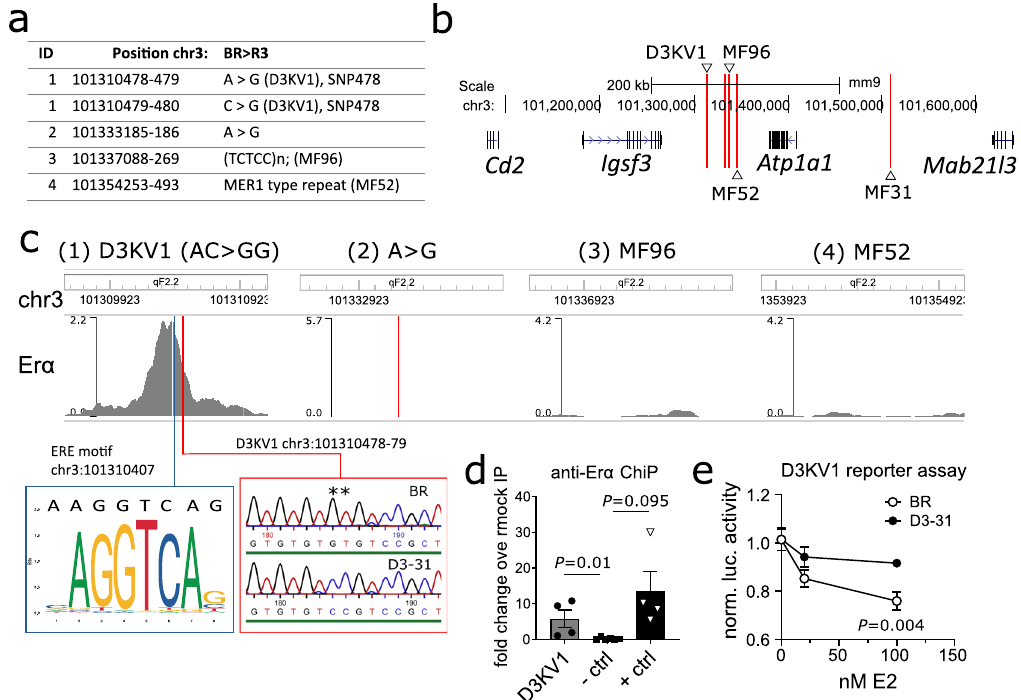
Fig. 4 Polymorphism in D3-31 ERBS affects E2-mediated transcriptional activity. a Sequencing results showing genetic variants within critical D3KV1- MF96 interval. b Detailed schematic overview of polymorphisms (denoted by red lines) in the D3KV1-MF96 interval. SNP478 denotes an AC > GG substitution on chr3:101310478-79. c ChIP-seq data from mouse uterus (extracted from SRX129062 63 ) showing Er α binding intensity to polymorphic regions listed in a . Consensus ER binding motif (UN0308.1 64 ) and SNP478 are highlighted in blue and red squares, respectively, where double asterisk indicates the position of SNP478. Coordinates according to mouse NCBI37/mm9 build. d Rabbit anti-mouse Er α ChIP-qPCR data con fi rming binding of Er